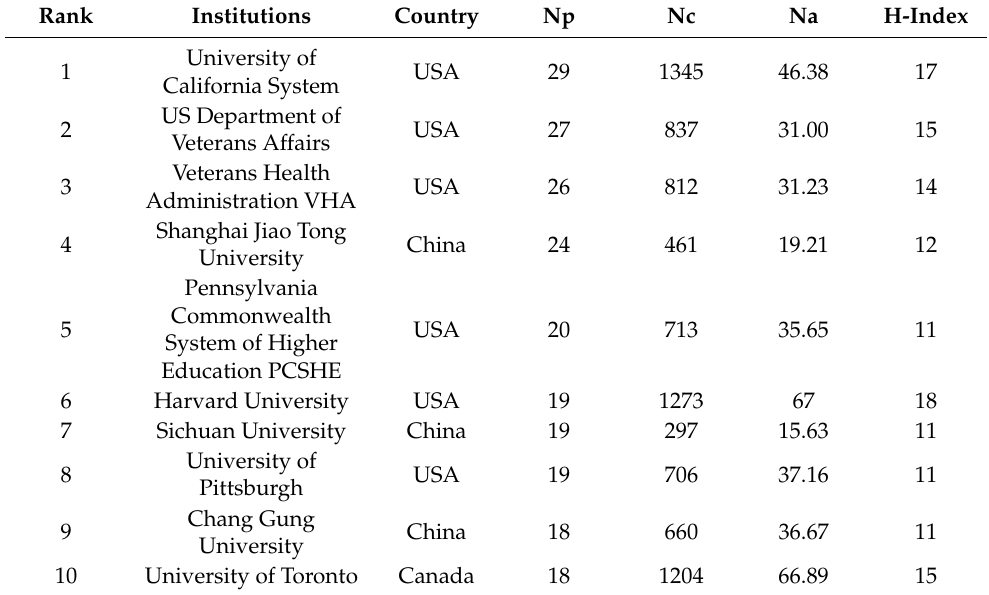
Figure 3. ( A ) Publications in the 10 most productive countries/regions. ( B ) The yearly number of local citation scores (LCS) of the 10 most productive countries/regions. ( C ) The country/region distribution of publications. Note: The blue shade indicates the number of publications, with darker blue indicating more publications. ( D ) The cooperation map of countries involving mitochondria in ALI. Note: The thicker the link between countries, the stronger the collaborative relationship, and vice versa. Table 2. The top 10 productive